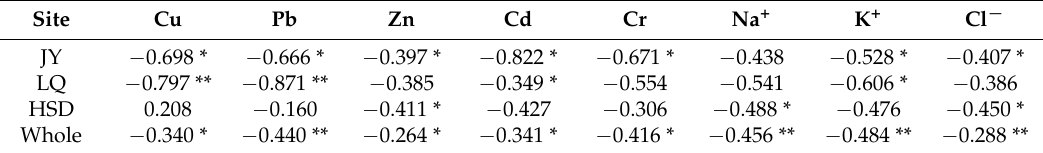
Table 4. Pearson correlation coefficients between the affected parameters and distances in